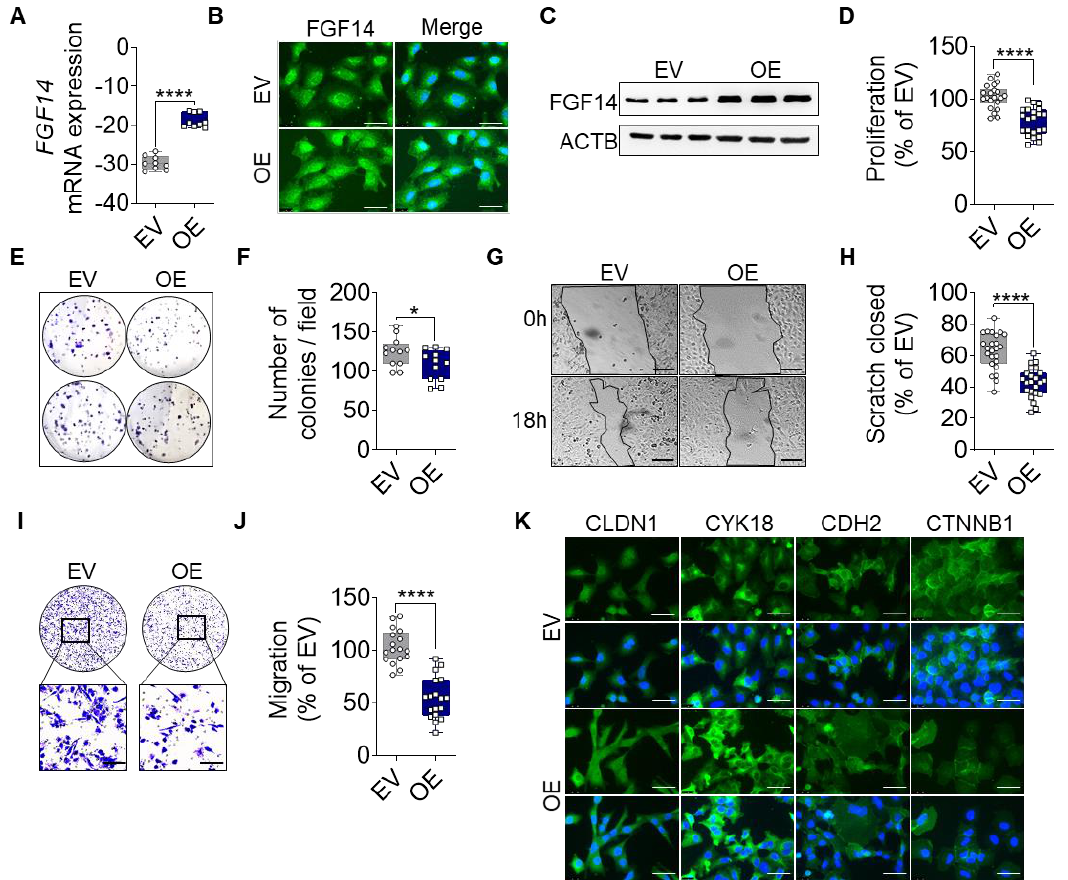
Figure 2. FGF14 overexpression reveals a tumor-suppressive phenotype in vitro. Validation of FGF14 overexpression after transfection of A549 cells with empty vector (EV) and FGF14 expression vector (OE) was quantified by ( A ) qRT-PCR, ( B ) immunocytochemistry (ICC) staining and ( C ) Western blot. Cells in B panel were labeled using FGF14 antibody and revealed by an AlexaFlour 488 secondary antibody (green). DNA was stained with 4′,6 -diamidino-2-phenylindole (blue), scale bars, 50µm. ( D ) Cellular proliferation was quantified by BrdU incorporation of FGF14 OE cells compared to EV control cells. ( E-F ) Colony formation of FGF14 OE cells compared with EV control cells. The migratory ability of FGF14 OE cells was assessed via ( G-H ) scratch assay and ( I-J ) Boyden chamber assay. Representative pictures were taken at 0 and 18 h after scratching; scale bars, 100µm. ( K ) ICC staining of epithelial (CLDN1, CYK18) and mesenchymal marker (CDH2, CTNNB1) labeled using an AlexaFlour 488 secondary antibody (green). DNA was stained with 4′,6 -diamidino-2-phenylindole (blue), scale bars, 50µm. Data are shown as mean ± standard error of the mean using Student’s t -test. P -values ≤ 0.05 were considered statistically significant for all analyses. ( n = 3) * p ≤ 0.05 and **** p ≤ 0.0001.